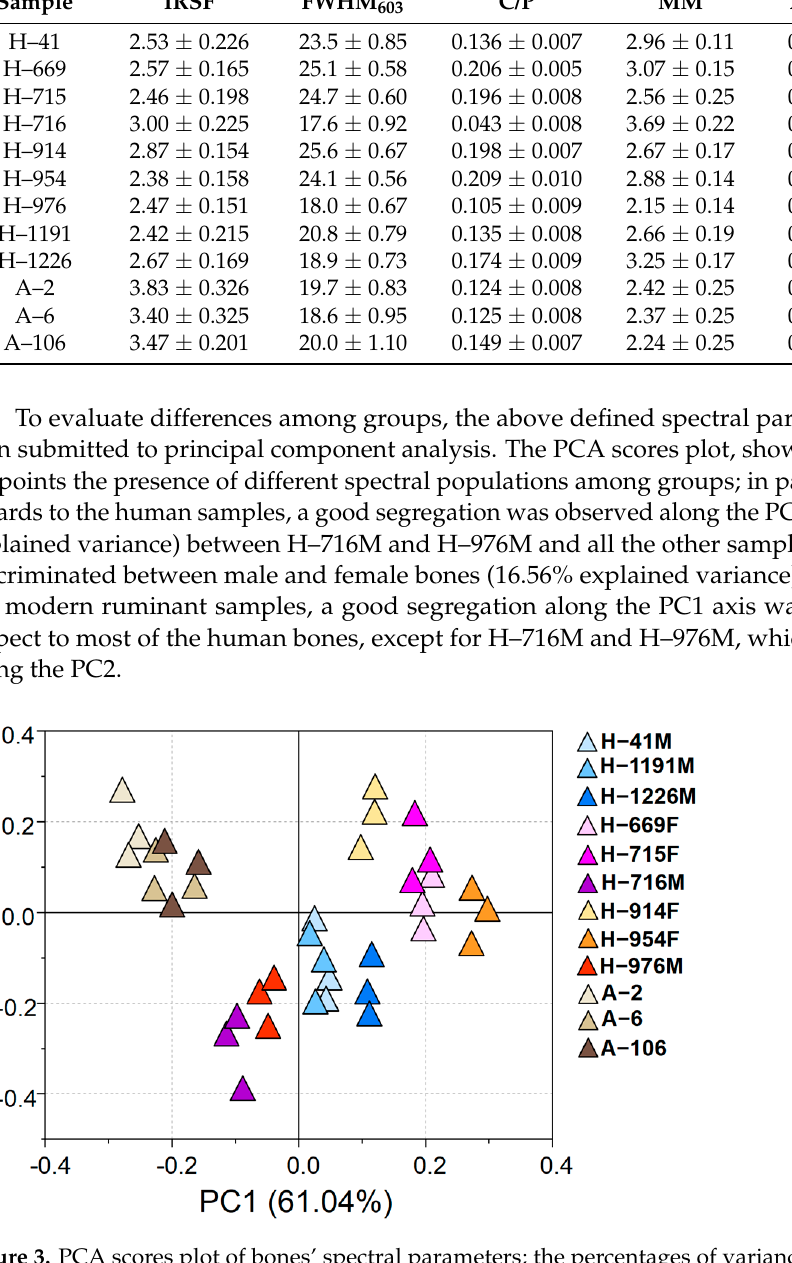
Table 2. Diagenetic parameters calculated by ATR–FTIR analysis of human and animal bone samples collected at the Fewet oasis: IRSF, FWHM 603 , C/P, MM, and amide I/PO 4 . Data are reported as mean ± S.D. Sample